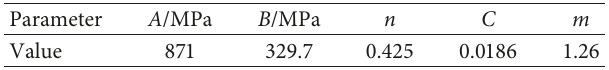
Table 3: Parameters of the Johnson-Cook constitutive model for U71Mn rail steel.